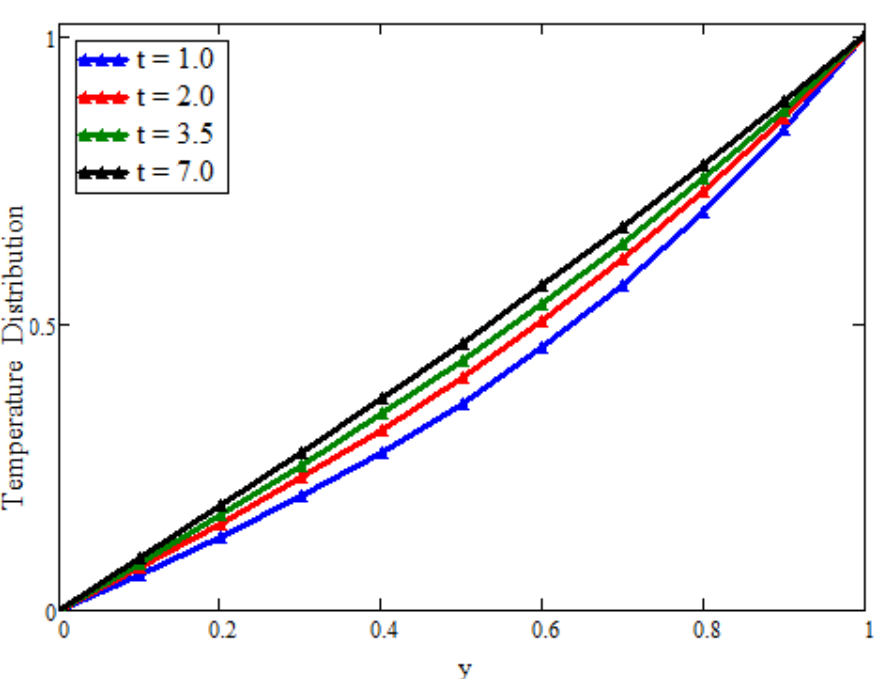
𝜙 (cid:3035)(cid:3041)(cid:3033) = 0.02, 𝛼 = 𝛽 = 𝛾 = 0.5 .